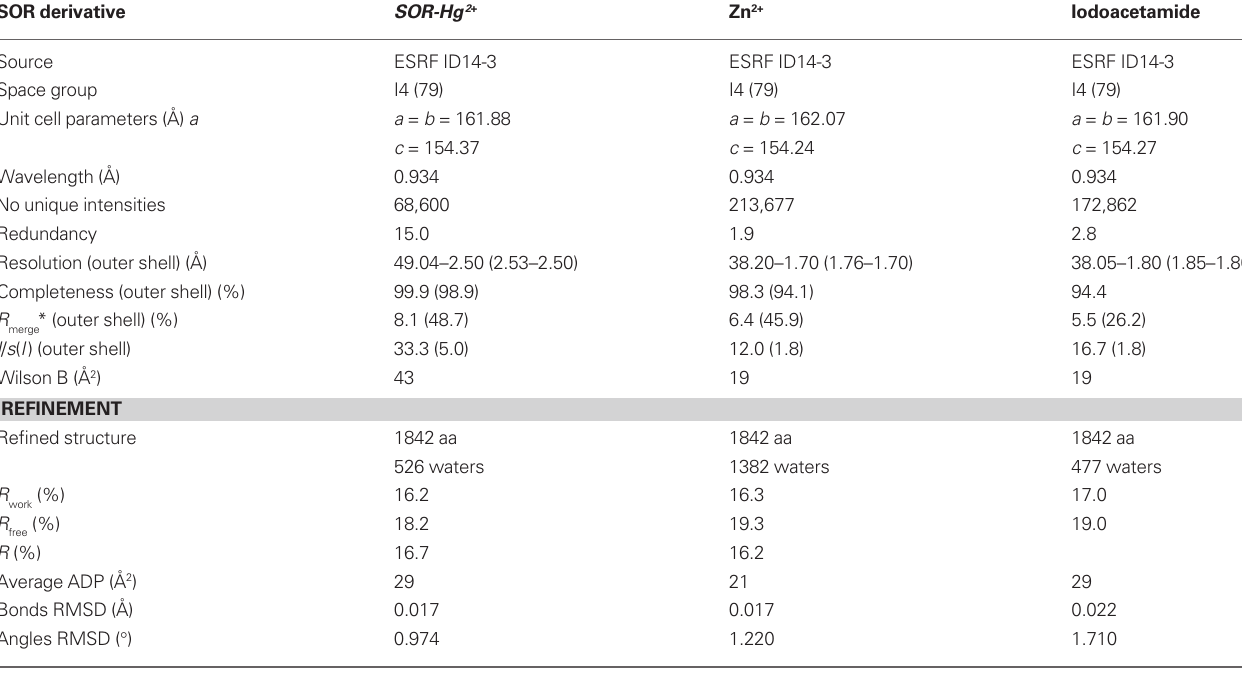
Table 3 | Diffraction data processing and refinement statistics. SOR